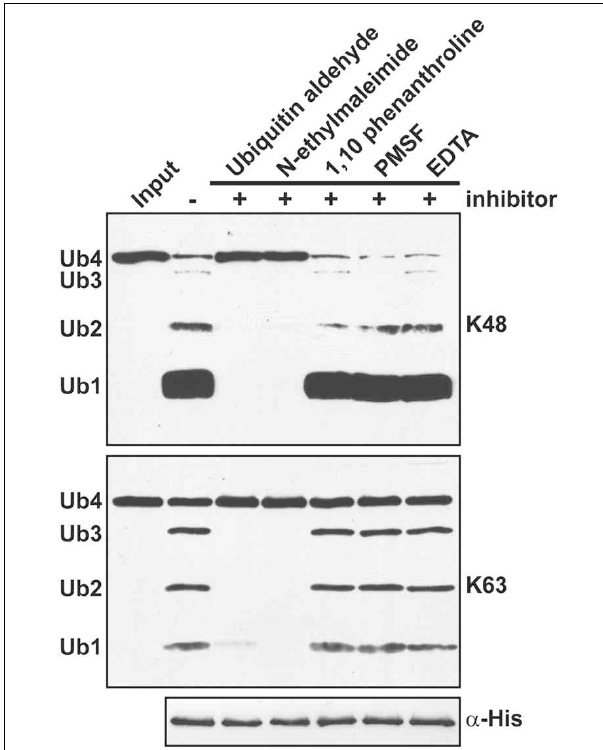
FIGURE 5 | A. thaliana OTU1 is catalytically inhibited by cysteine protease inhibitors. The effects of different protease inhibitors on the cleavage activity of His-tagged A. thaliana OTU1 (300nM) for K48- and K63-linked UB tetramers (250 ng) were examined by comparing the resulting cleavage products after pre-incubation (5min at 4 ◦ C) and the catalytic reaction (1h at 37 ◦ C) in the absence ( − ) and presence ( + ) of 0.5 μ M UB aldehyde, 0.5 μ M N-ethylmaleimide, 0.5 μ M 1,10-phenanthroline, 1mM phenylmethylsulfonyl fluoride (PMSF), or 1mM EDTA. The input substrate incubated without OTU1 was used as a negative control (Input). The input Ub4 and cleavage products Ub3, Ub2, and Ub1, labeled on the left, were detected by immunoblotting with α -UB. Duplicate samples were examined using antisera against the His-tag to confirm that OTU1 was input at equivalent levels ( α -His).